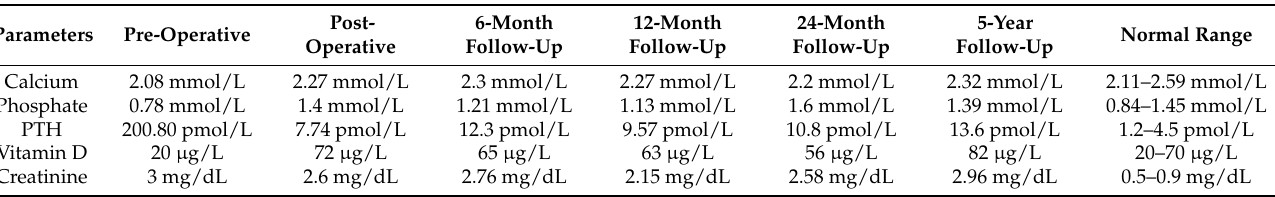
Table 1. Patient blood values before surgery and follow-up.